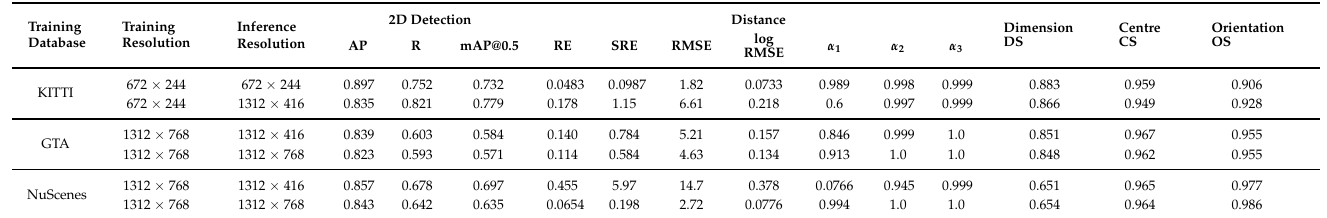
Table 2. Quantitative evaluation of YOLOv5-3d on KITTI after training on different